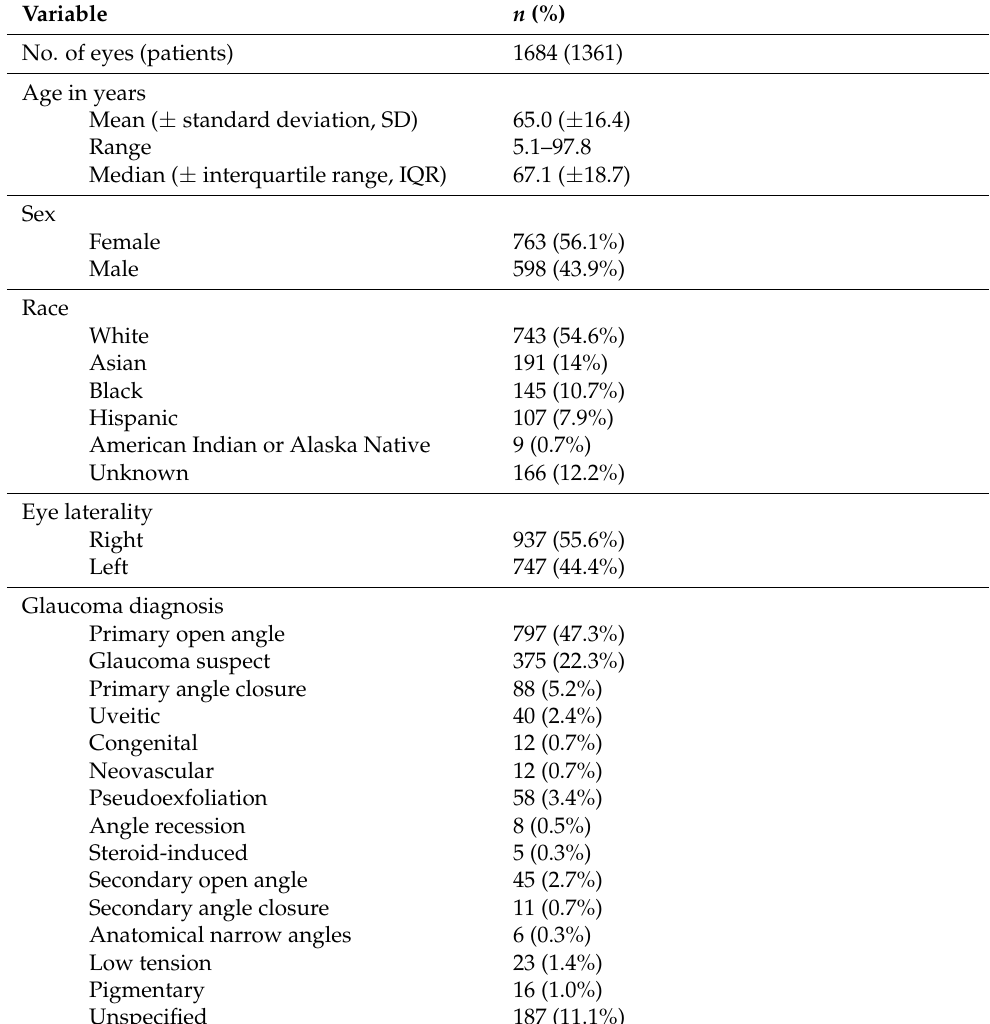
Table 1. Demographic and clinical characteristics of the study population.